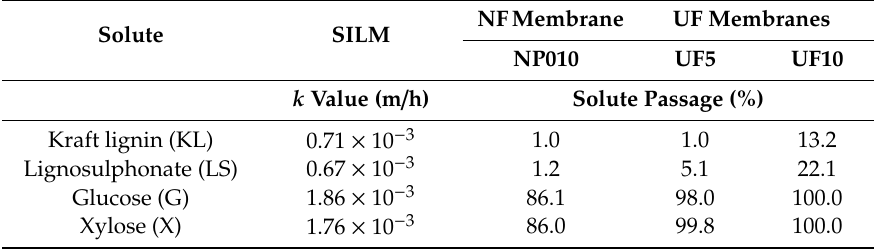
Table 4. Solute permeability values k of the SILM and solute passage percentages of the NF and UF membranes.